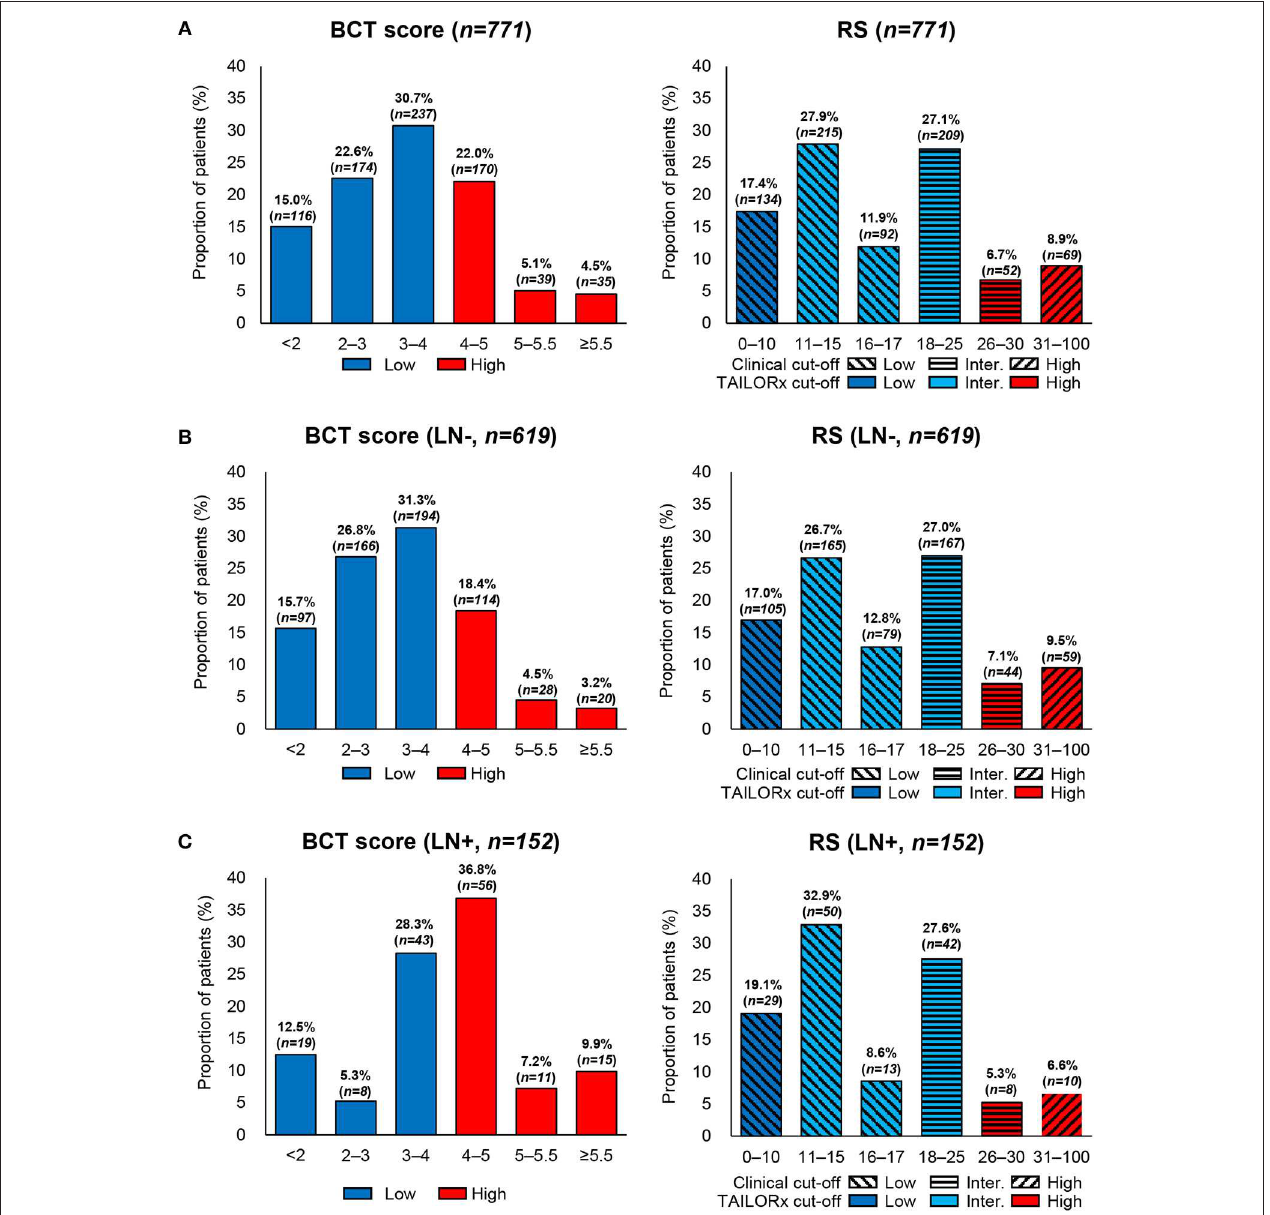
FIGURE 1 | Distribution of the BCT score and Oncotype DX RS by nodal status. Proportion of patients within each risk score range or risk group in (A) all patients ( n = 771), (B) lymph node-negative (LN-) patients ( n = 619), and (C) lymph node-positive (LN + ) patients ( n = 152).